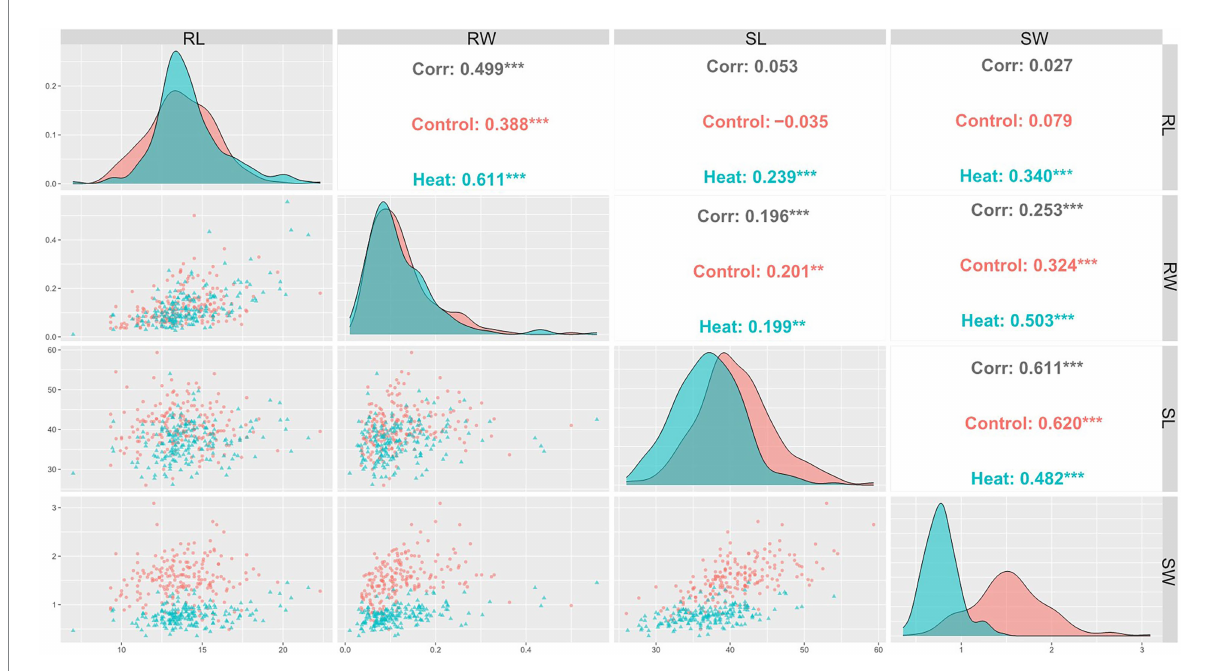
FIGURE 2 Pearson’s correlation coefficients describing association of various traits in wheat under control and HS